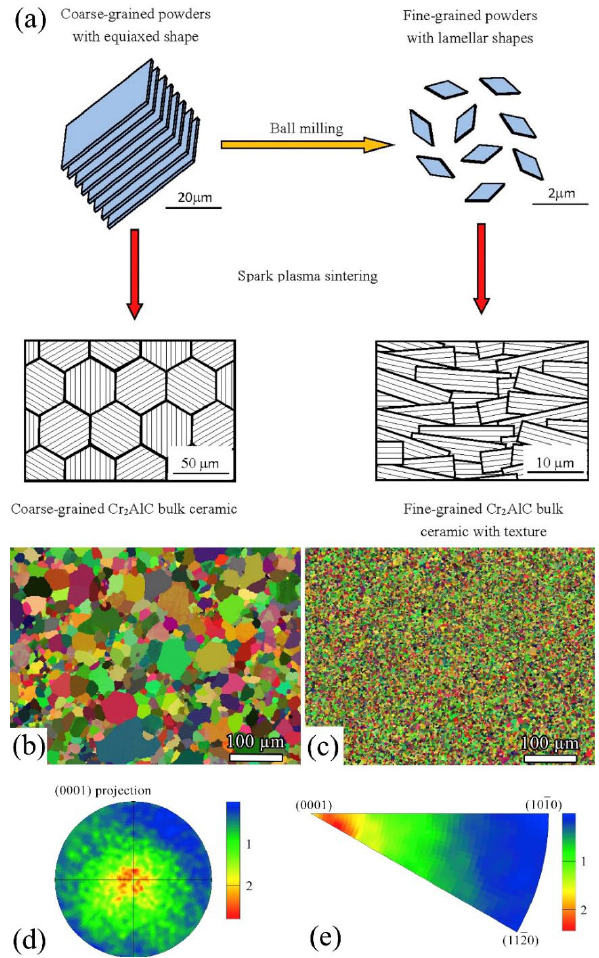
Fig. 14 Preparation and characterization of coarse- grained Cr 2 AlC ceramic without texture and fine-grained Cr 2 AlC ceramic with texture: (a) schematic diagrams of preparation; (b, c) Euler maps of untextured and textured specimens, respectively; (d, e) (0001) pole figure and inverse pole figure of textured Cr 2 AlC specimen surface perpendicular to the sintering pressure, respectively. Reproduced with permission from Ref. [123], © Elsevier Ltd. 2014.